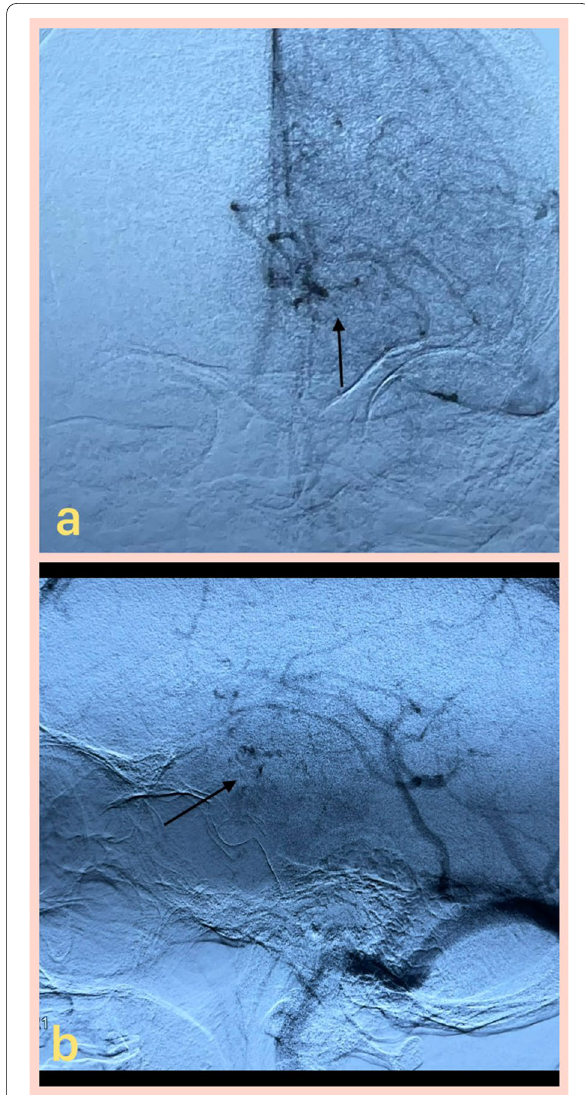
Fig. 3 Antero-posterior ( A ) digital subtraction angiography (DSA) image in early venous phase of the left internal carotid artery angiogram shows filling of venous pouches in the region of the mass(denoted by black arrow). Lateral DSA image ( B ) of the left internal carotid artery angiogram in late venous phase showing angiographic blushing in left parasellar region (denoted by black